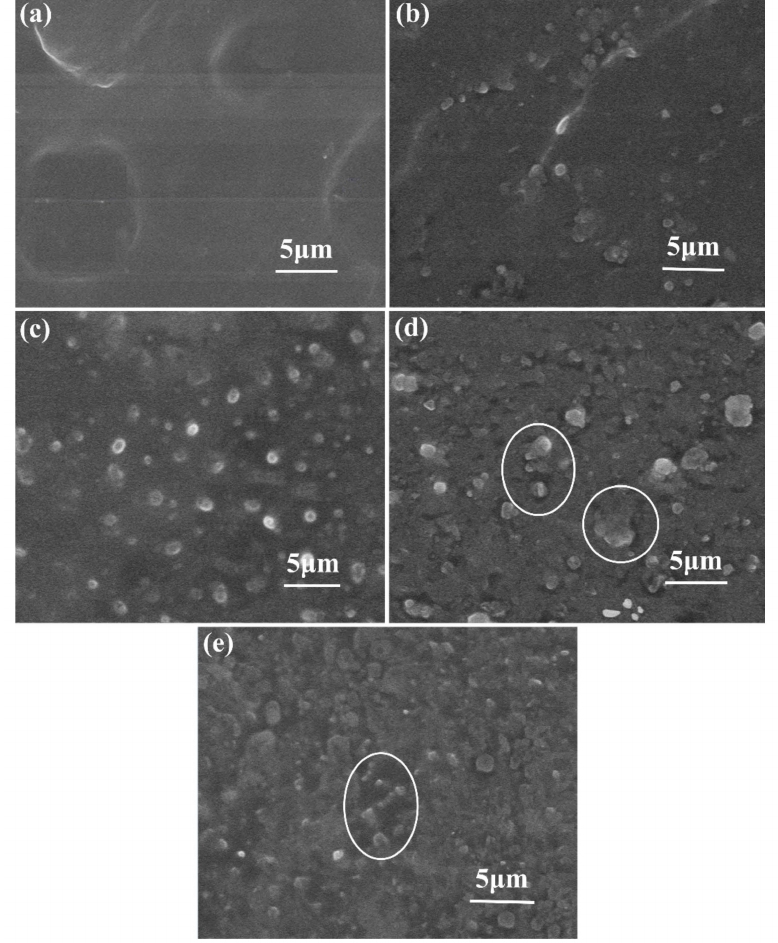
Figure 3. SEM cross-sectional view of h-BN / LDPE composite sample doped with h-BN fillers: ( a ) 0, ( b ) 1, ( c ) 3, ( d ) 5, ( e ) 10